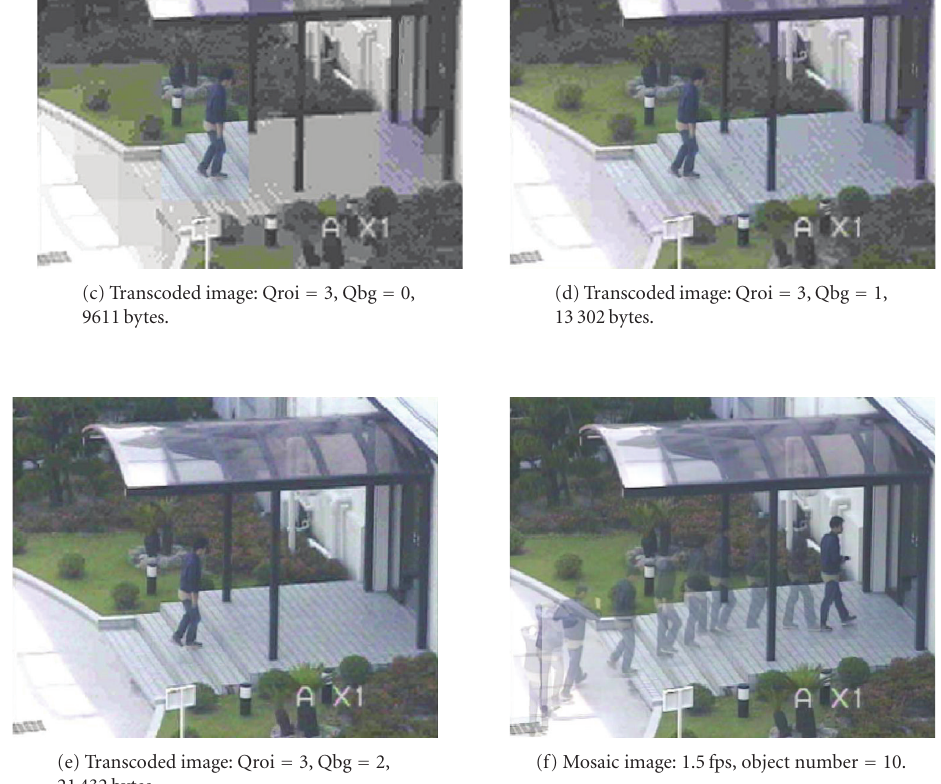
Figure 3: Example images corresponding to various ROI-based streaming methods and parameter settings.